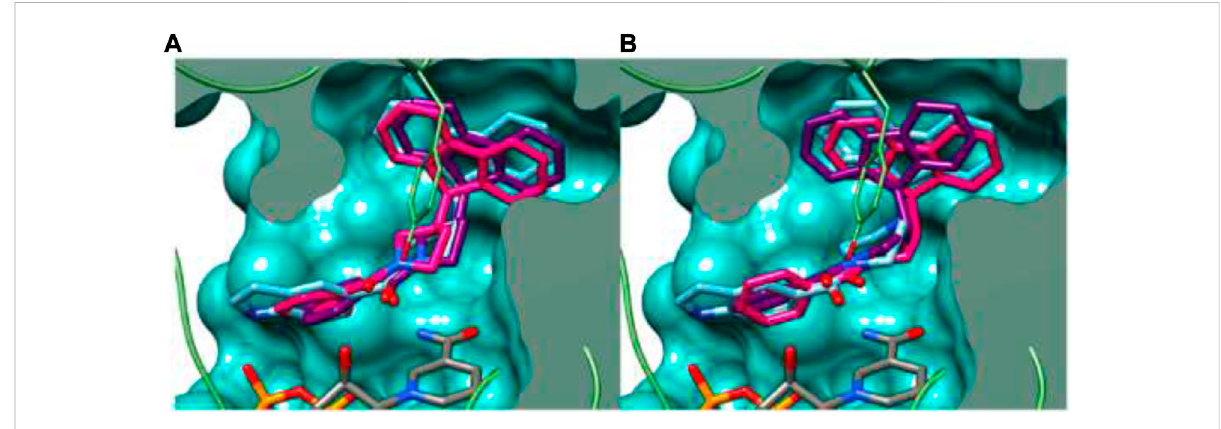
FIGURE 7 Binding mode of 77a with InhA; (A) (R)-enantiomer and (B) (S)-enantiomer. Reproduced from Matviiuk et al., 2016, with permission from Elsevier, Copyright